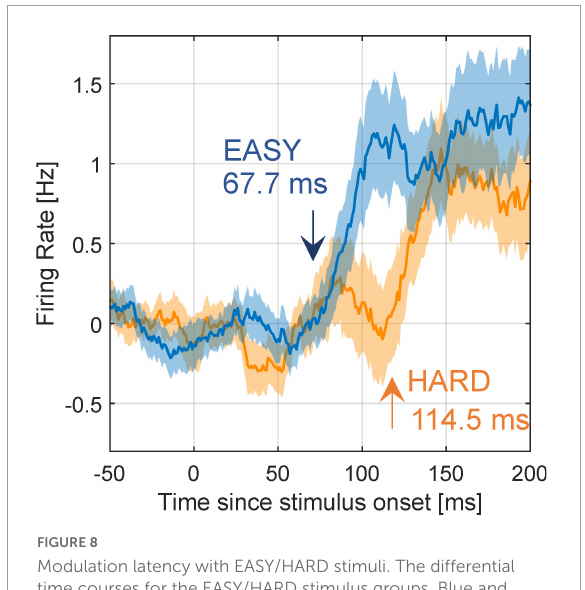
FIGURE8 Modulation latency with EASY/HARD stimuli. The differential time courses for the EASY/HARD stimulus groups. Blue and orange lines indicate the mean time courses for EASY and HARD stimulus groups, respectively, across all FG neurons, and shades indicate SEs. Two-phase regression was applied to these time courses to compute modulation latencies. The inset values are the estimated modulation latencies.